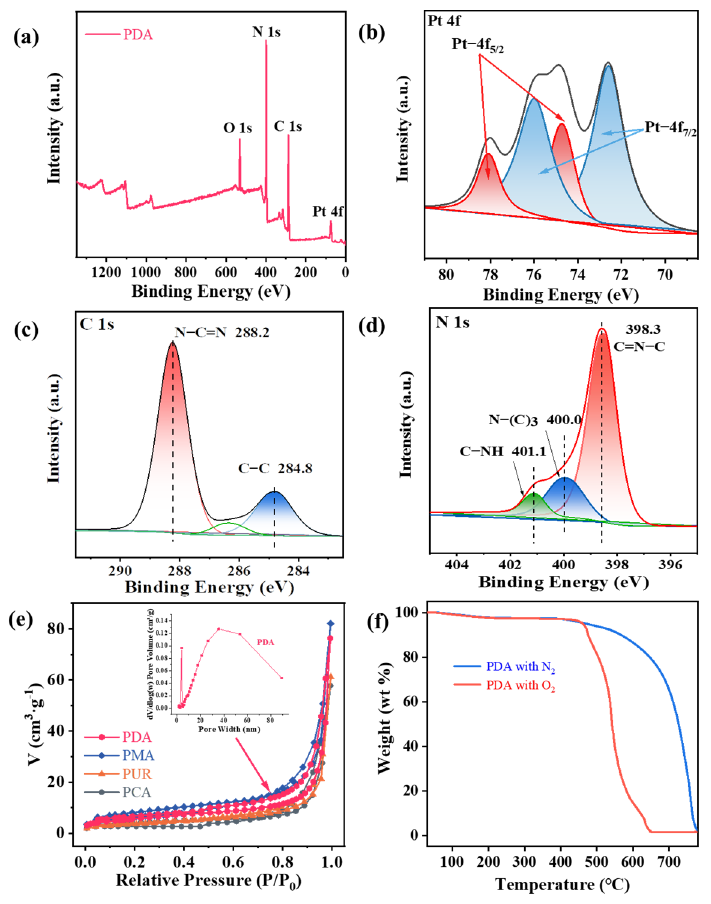
Figure 3. XPS spectra of ( a ) survey, ( b ) Pt 4f, ( c ) C 1s, ( d ) N 1s, ( e ) BET patterns, ( f ) thermalgravimetric curves of PDA.